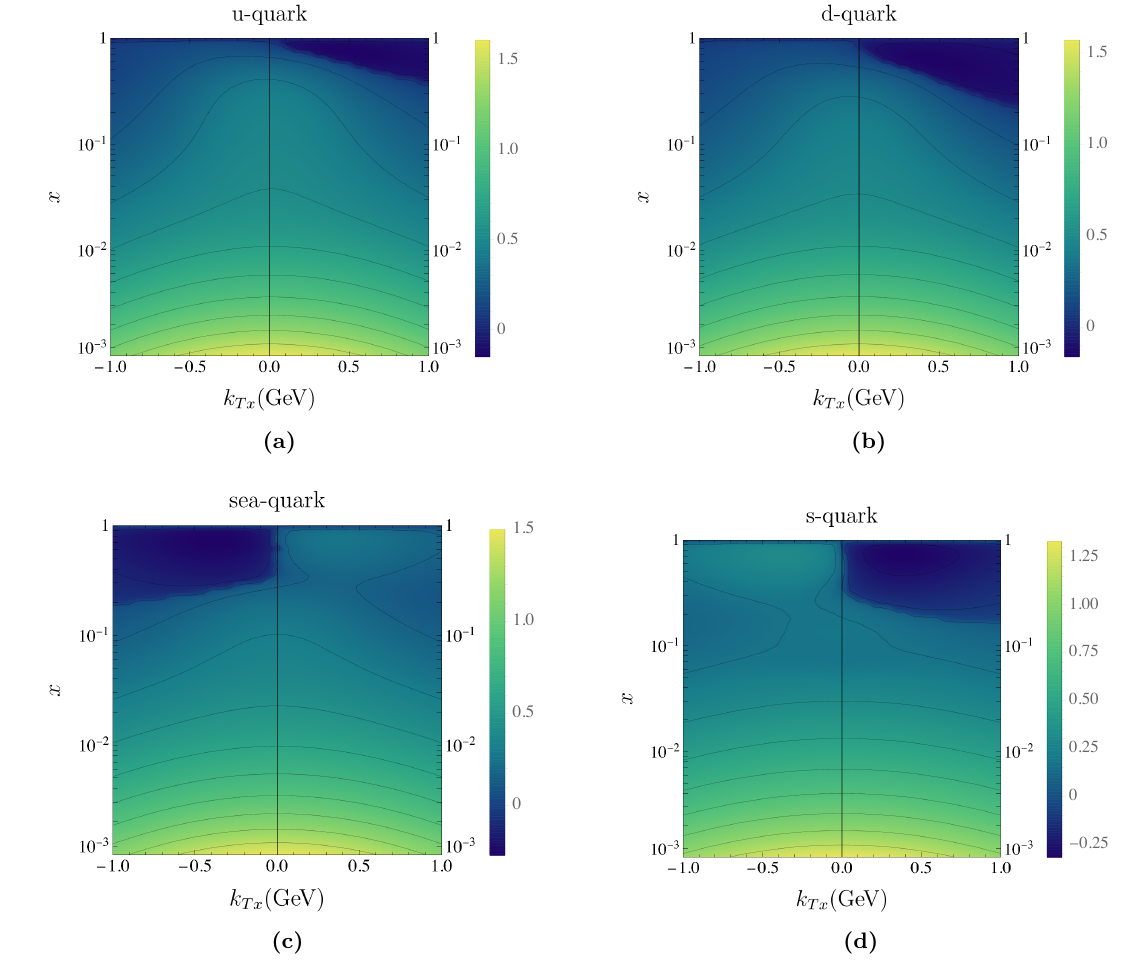
Figure 19. Tomographic scan of the nucleon in ( x, k T ) via the momentum space quark density function ρ ( x, k ) defined in eq. (4.7) at µ = 2 GeV. Panel (a) is for u -quarks, panel (b) T , S T , µ 1; q ← h ↑ is for d -quark, panel (c) is for sea -quark, and panel (d) is for s -quark. The color scheme is defined as explained in the